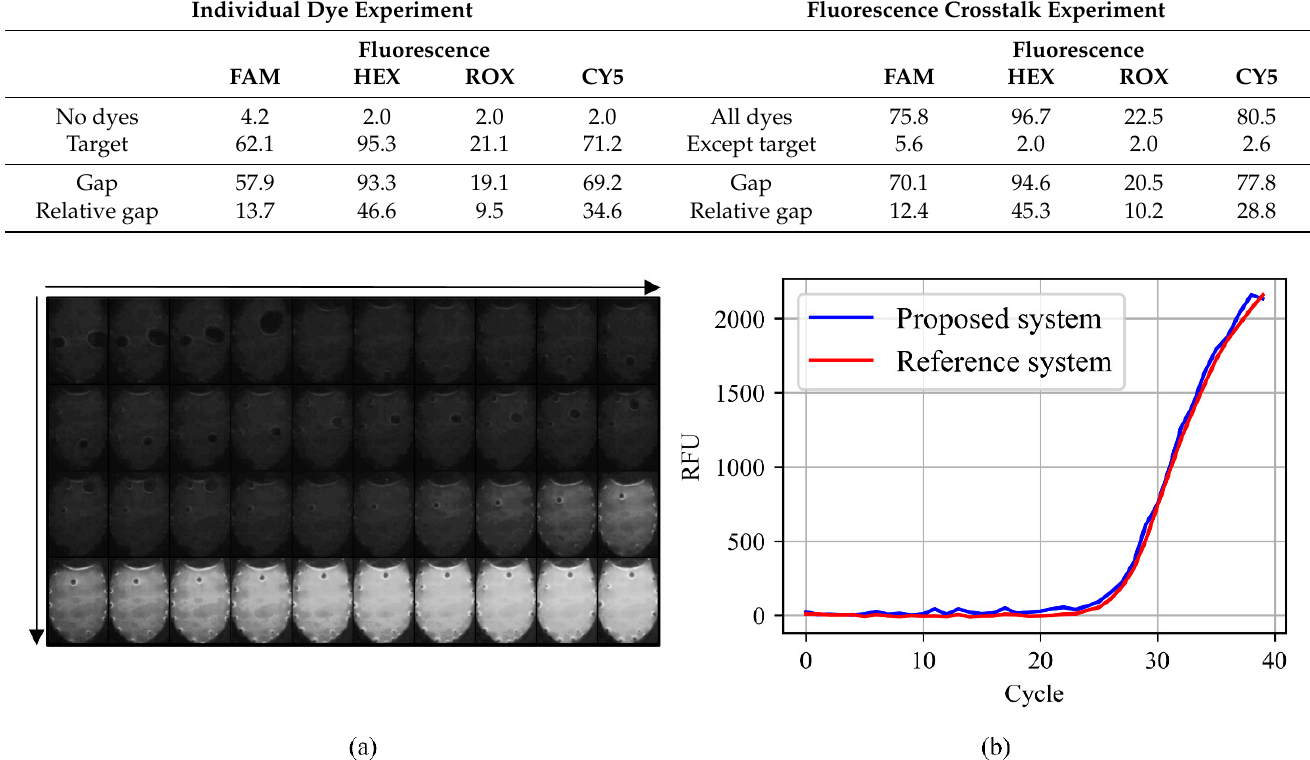
Figure 10. The change in the brightness of the chamber during 40 cycles (images have improved brightness for visibility), and the amplification curves from the proposed and reference system. ( a ) Fluorescence images of the chamber for 40 cycles; ( b ) Amplification curve of the reference system that uses a photodiode (red) and the proposed system with a CMOS camera (blue).